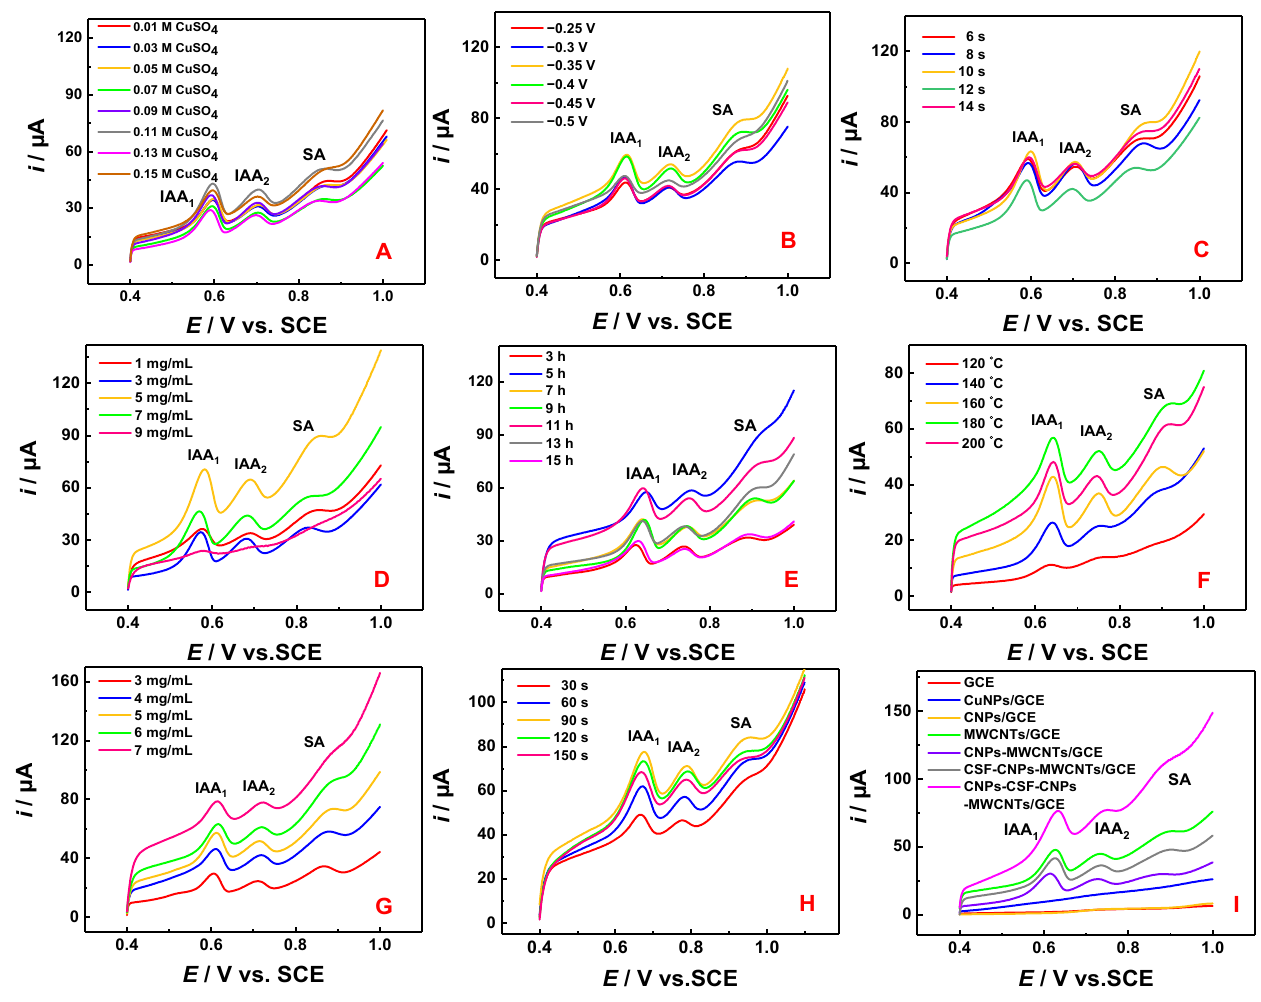
Figure 5. Effects of CuSO 4 concentration ( A ), deposition potential ( B ), deposition time ( C ), concentration of CNPs ( D ), hydrothermal time ( E ), hydrothermal temperature ( F ), concentration of MWCNTs ( G ) and the preconcentration time ( H ) on LSV peak current of CuNPs-CSF-CNPS-MWCNTs/GCE in 0.1 M PBS (pH = 7) containing 50 μ M IAA and 50 μ M SA. LSV ( I ) of GCE, CuNPs/GCE, CNPs/GCE, MWCNTs/GCE, CNPs-MWCNTs/GCE, CSF-CNPs-MWCNTs/GCE and CuNPs-CSF-CNPs-MWCNTs/GCE modified electrodes in 0.1 M PBS (pH = 7) containing 50 μ M IAA and 50 μ M SA. Scan rate of 100 mV/s.